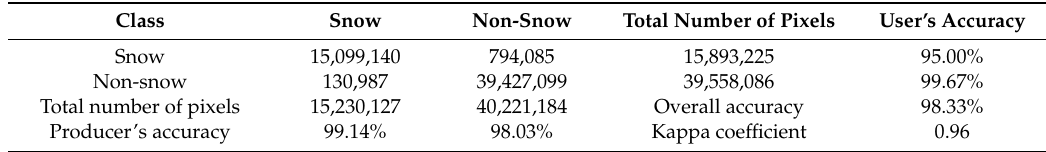
Table 3. Accuracy assessment of image